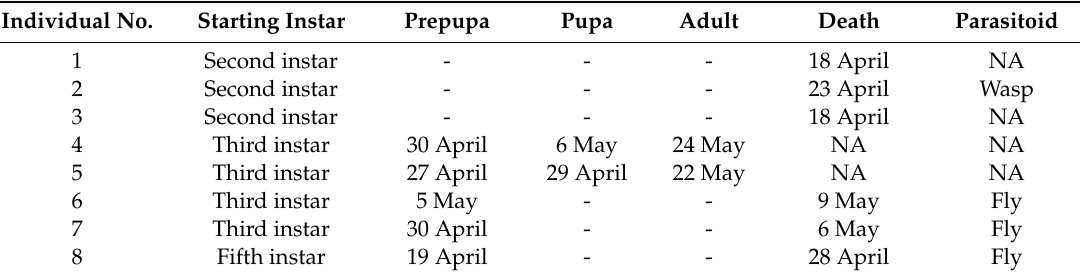
Table 3. Rearing of larvae from